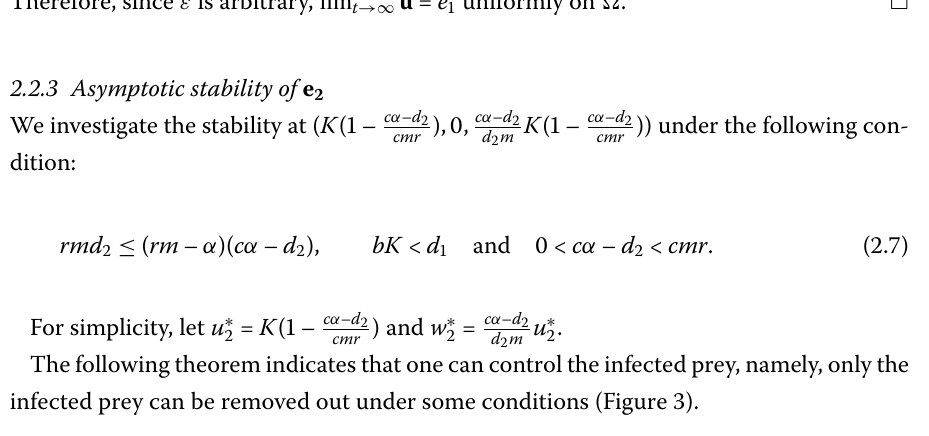
) K > (cid:8) follows from the comparison r ( m –) ε + (cid:8)